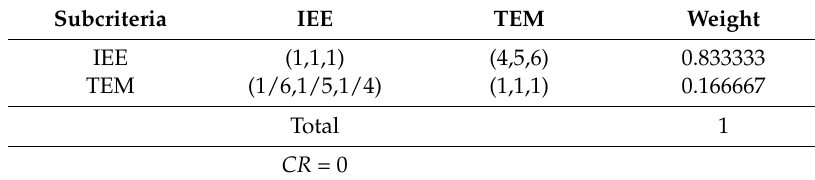
Table A15. Comparison matrix for EQR.